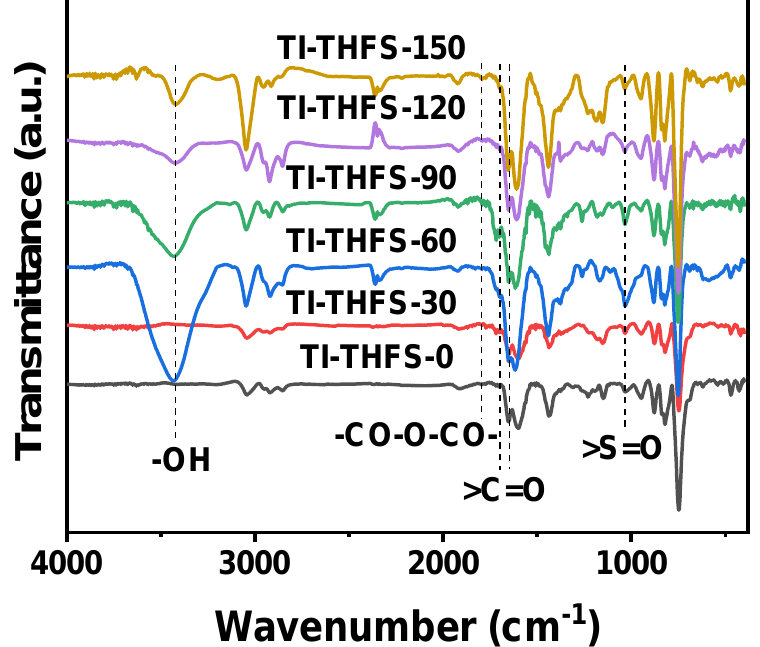
Figure 8. FT-IR spectra of the TI-THFS fraction in spinnable pitch at different incubation Figure 8. FT − IR spectra of the TI − THFS fraction in spinnable pitch at different incubation days.